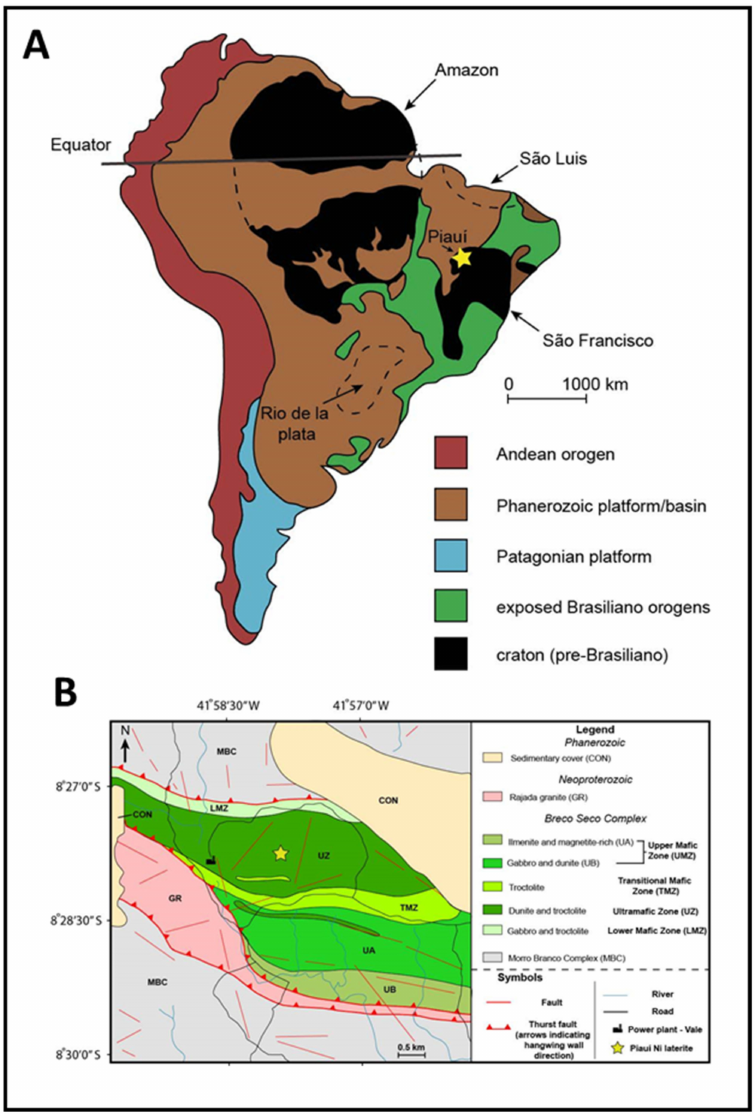
Figure 1. ( A ) The Amazonian, S ã o Luis, S ã o Francisco and Rio de la Plata continental cratons of South America with the poorly exposed areas indicated with dashed lines and the location of the Piau í laterite shown by a star. Modified after [24]. ( B ) A geological map of the Brejo Seco Complex with the location of the Piau í deposit shown by a star. Modified after